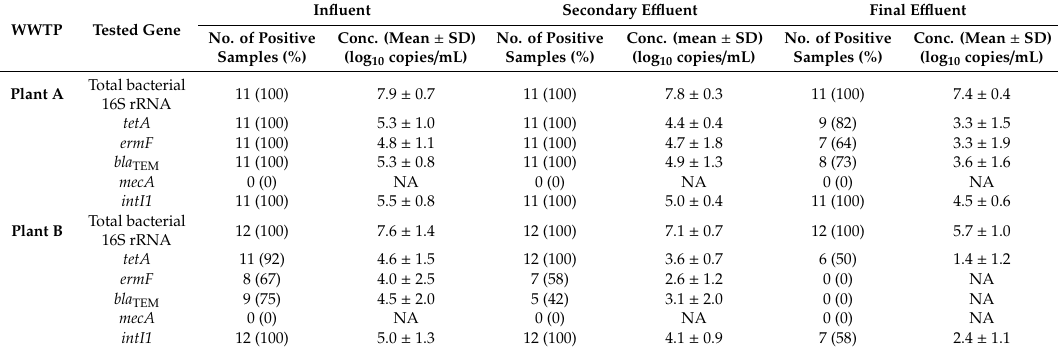
Table 1. Detection of total bacterial 16S rRNA, ARGs, and intI1 in wastewater samples.